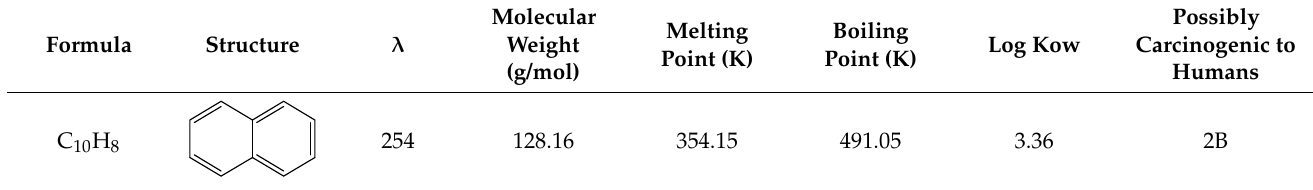
Table 1. Characteristic of Nap.